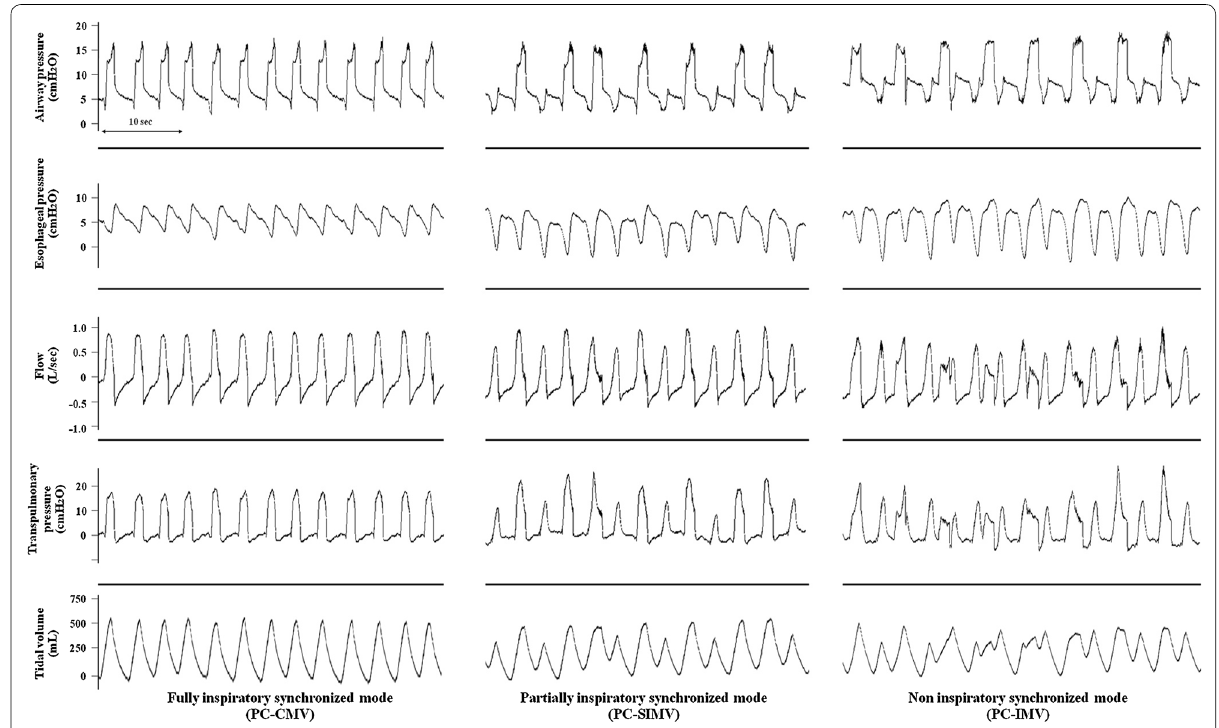
Fig. 1 Tracings of airway pressure, esophageal pressure, flow, transpulmonary pressure, and tidal volume during each pressure‑controlled mode of ventilation. The degree of inspiratory synchronization leads to varying in transpulmonary pressure and tidal volume. PC-CMV pressure‑controlled continuous mandatory ventilation, PC-SIMV pressure‑controlled synchronized intermittent mandatory ventilation, PC-IMV pressure‑controlled intermittent mandatory